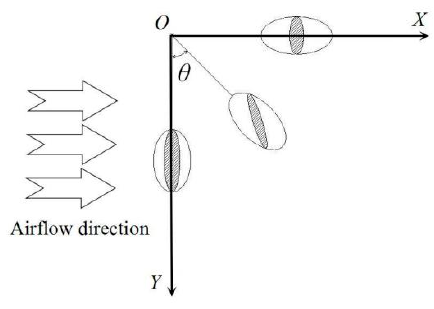
Figure 2. Schematic of the Chinese wolfberry projection area at different oscillation